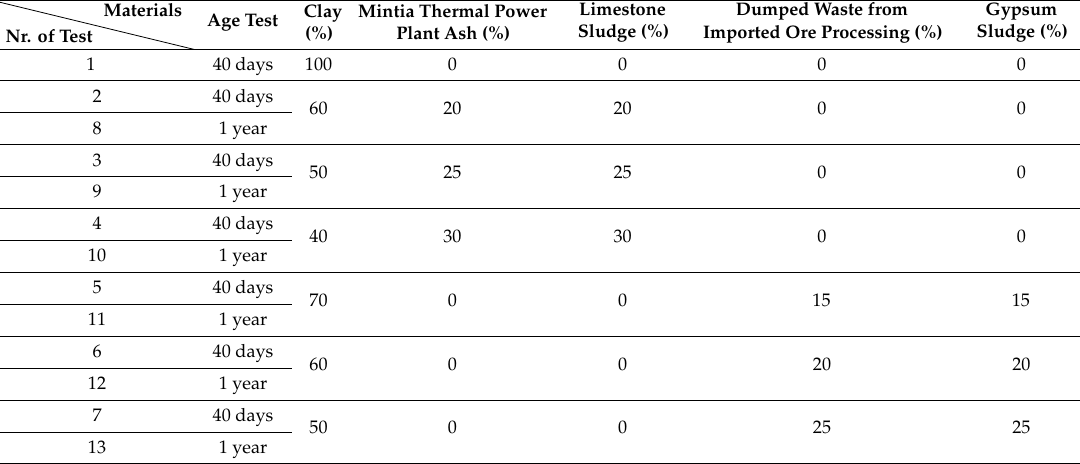
Table 5. Compositions of experimentally tested mixtures.